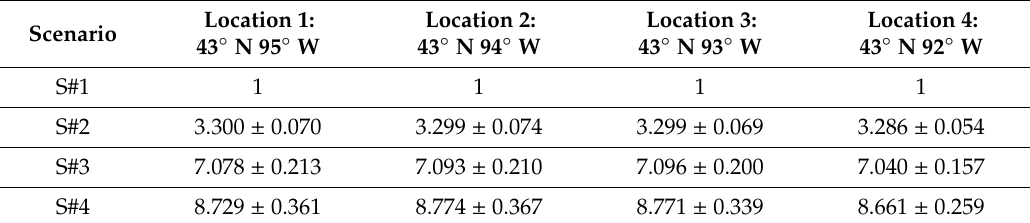
Table 2. Mean P cx for each WT scenario relative to scenario S#1 computed using output for all 10-min periods during December 2007–August 2008. The values shown denote the mean of the monthly mean values plus / minus one standard deviation of the monthly values.